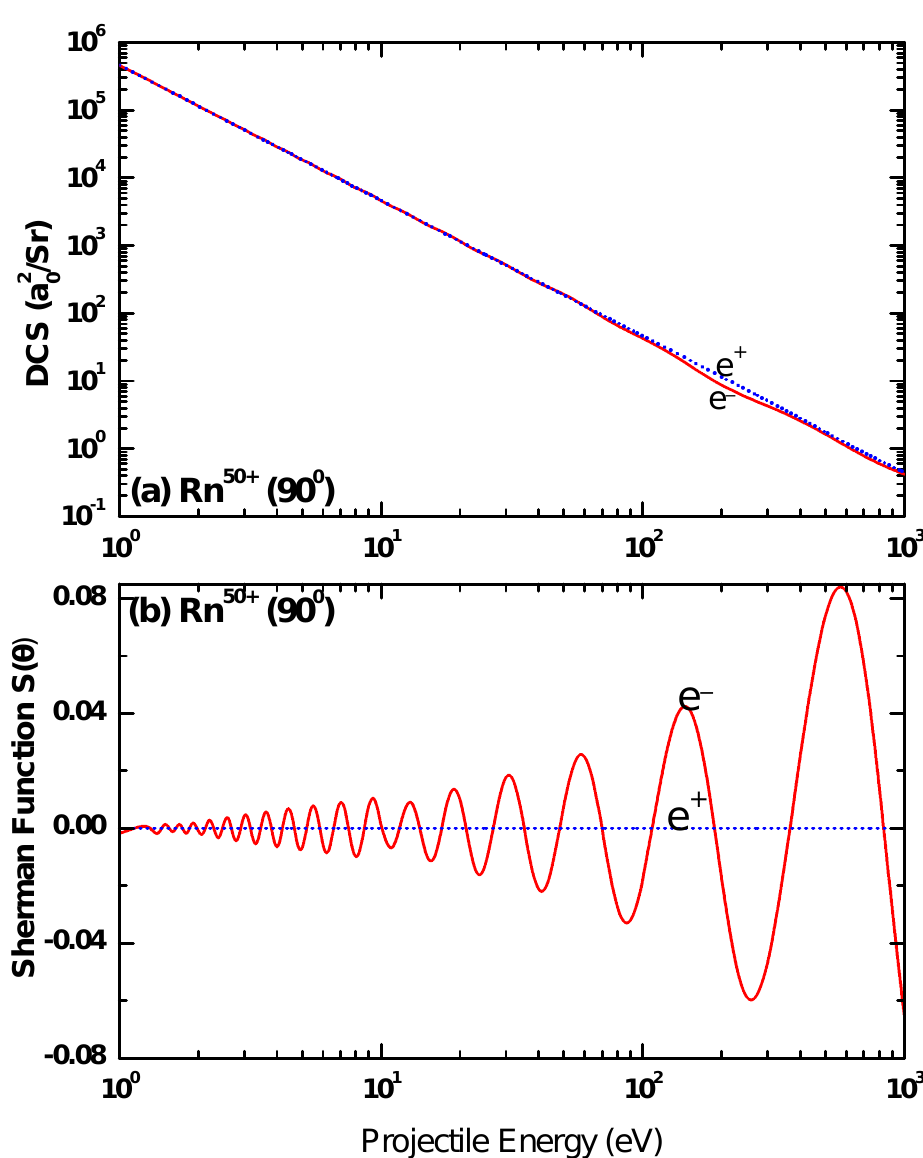
Figure 34. Comparison of ( a ) the differential cross section and ( b ) the corresponding Sherman function for the collisions of electrons and positrons from Rn 50 + ion targets at the scattering angle of 90 ◦